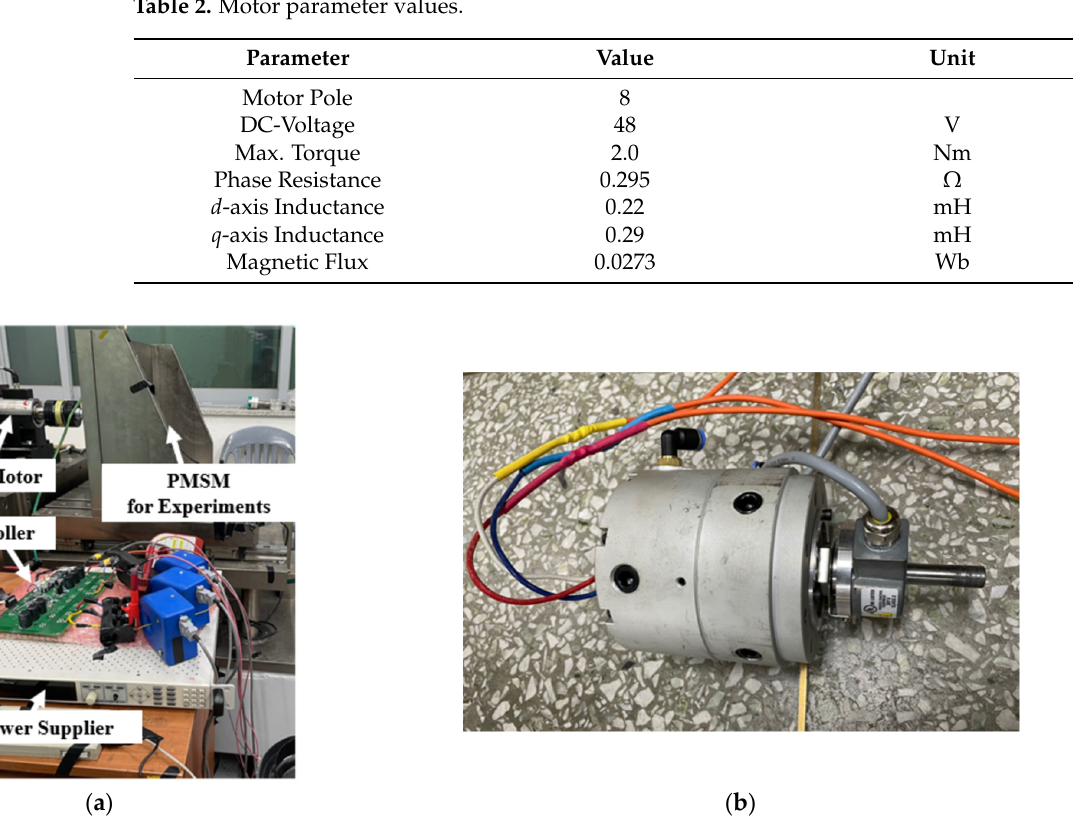
Figure 15. ( a ) Experimental setup ( b ) Motors used during the test.